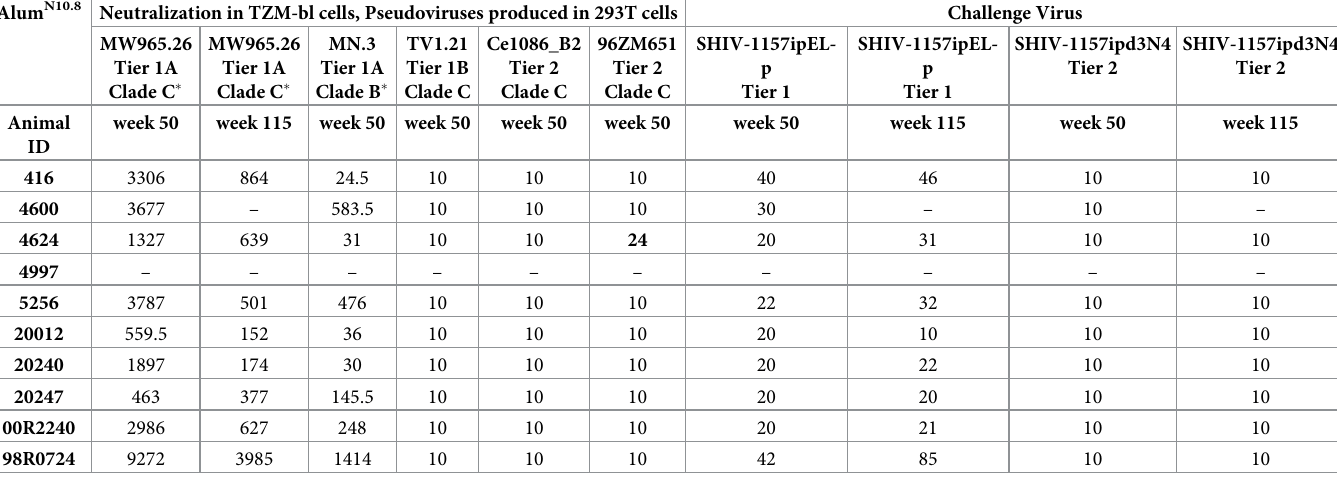
Table 4. Serum neutralizing activity in animals immunized in Study 2 (Alum N10.8